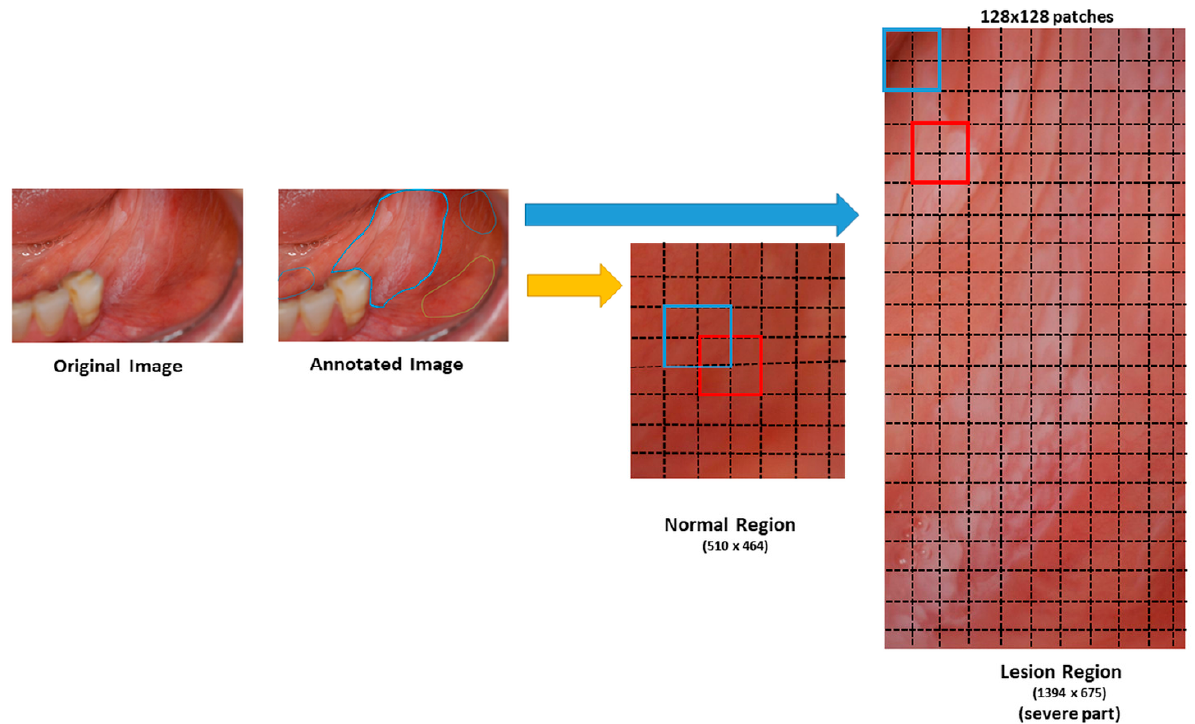
Figure 4. Figurative image patching from bounding box lesion and normal area into 128 × 128 patches. Original images were annotated by dentists. We cropped the bounding box of the annotated regions as normal or suspicious regions. The cropped regions were divided into 128 × 128 pixel image patches (red and blue squares) with a stride of 64 pixels (dotted lines), resulting in overlapping patches. If the size of the image was not a multiple of 128 × 128, the patches were not obtained from the remainder of the image. If the patches with more than 80% pixels originated from a suspicious area, they were labeled as suspicious patches; otherwise, they were considered as normal patches.